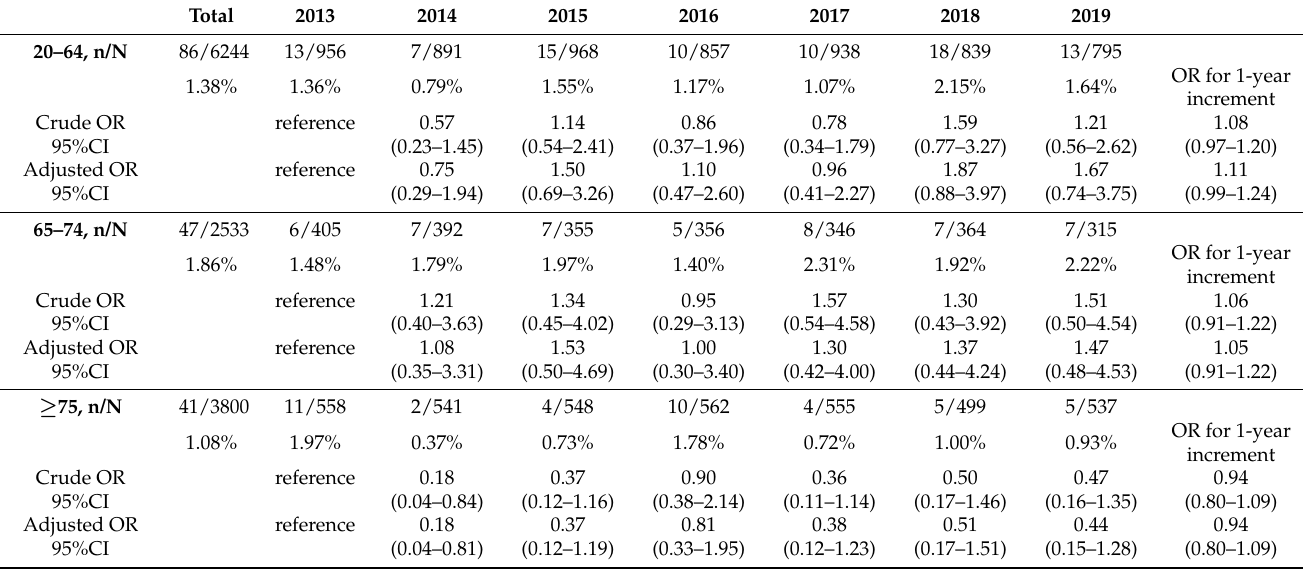
Table 3. One-month survival of patients with traumatic out-of-hospital cardiac arrests after traffic accidents over time by age group.